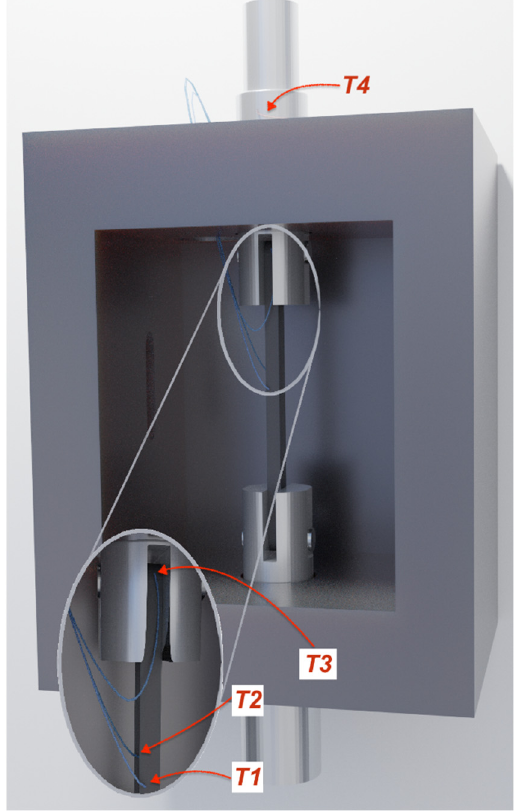
Figure 17. Position of thermocouples in chamber.